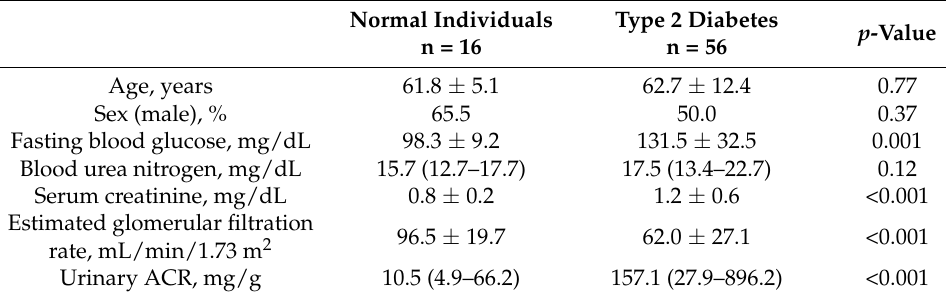
Normal Individuals Normal Individuals Type 2 Diabetes p -Value n = 16 n = 56